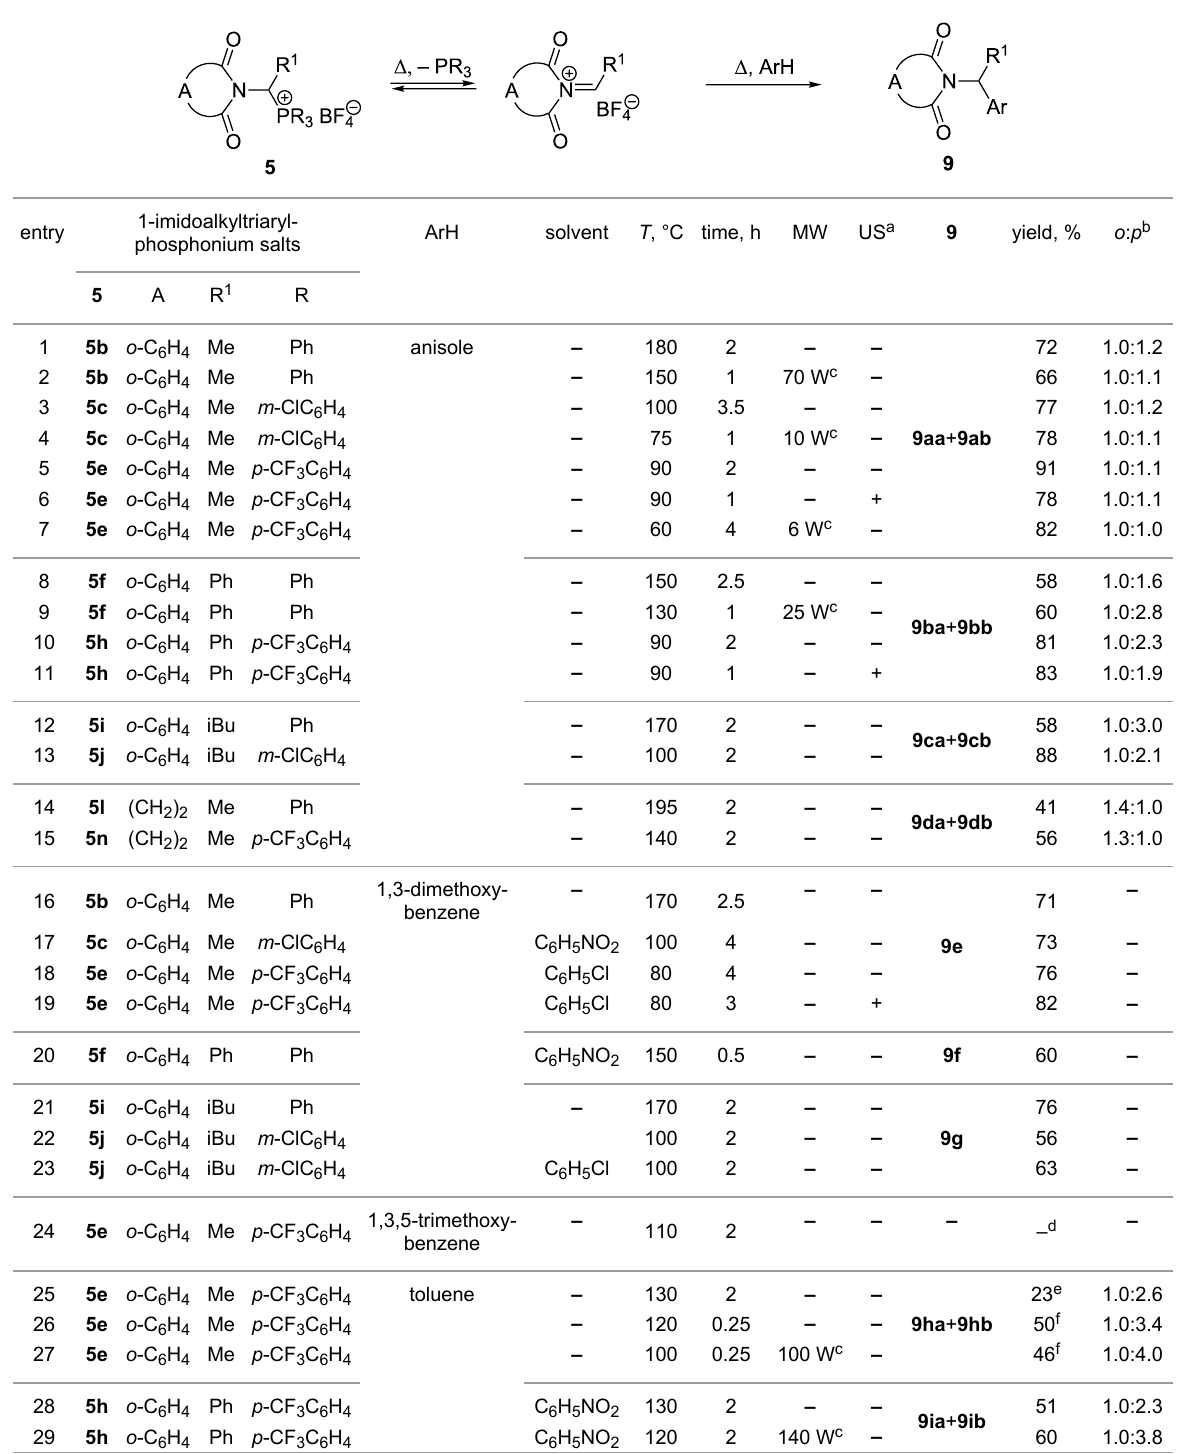
Table 3: Synthesis of N -(1-arylalkyl)imides 9